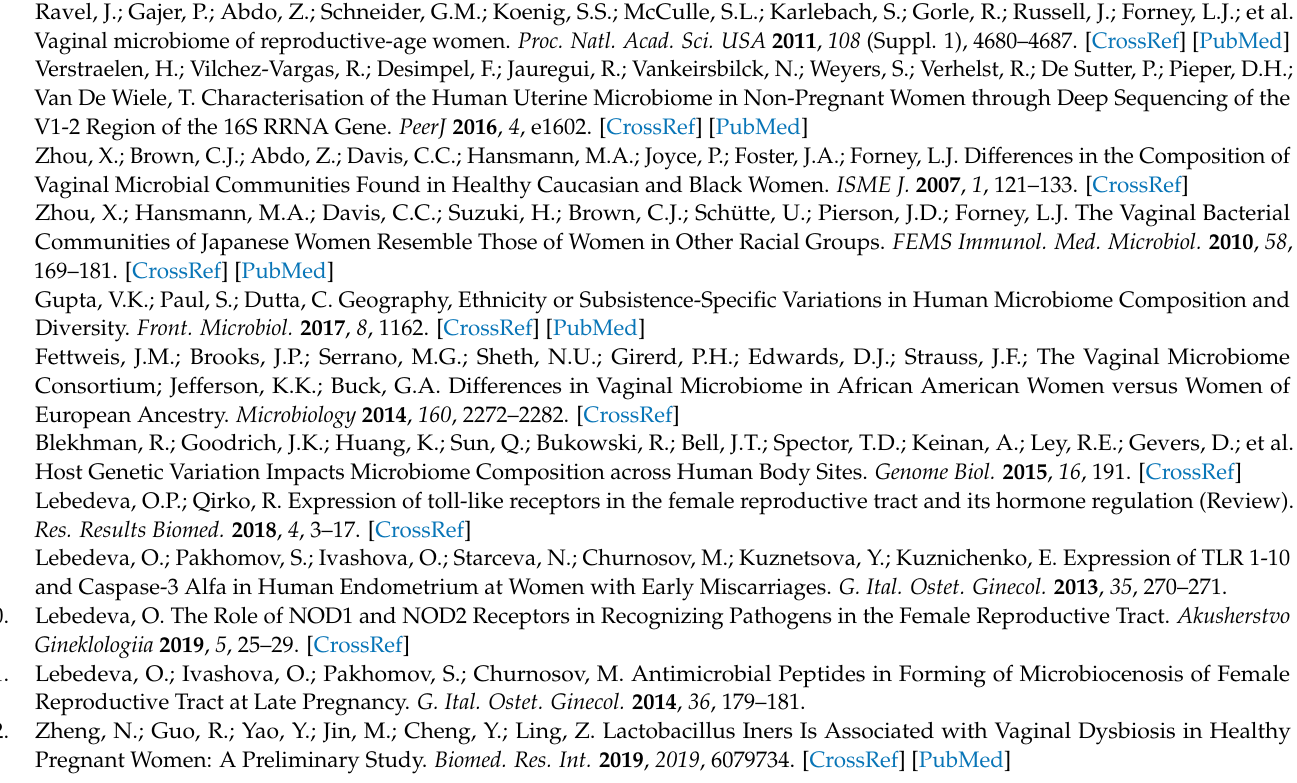
Table S2: The full bacterial composition of the studied